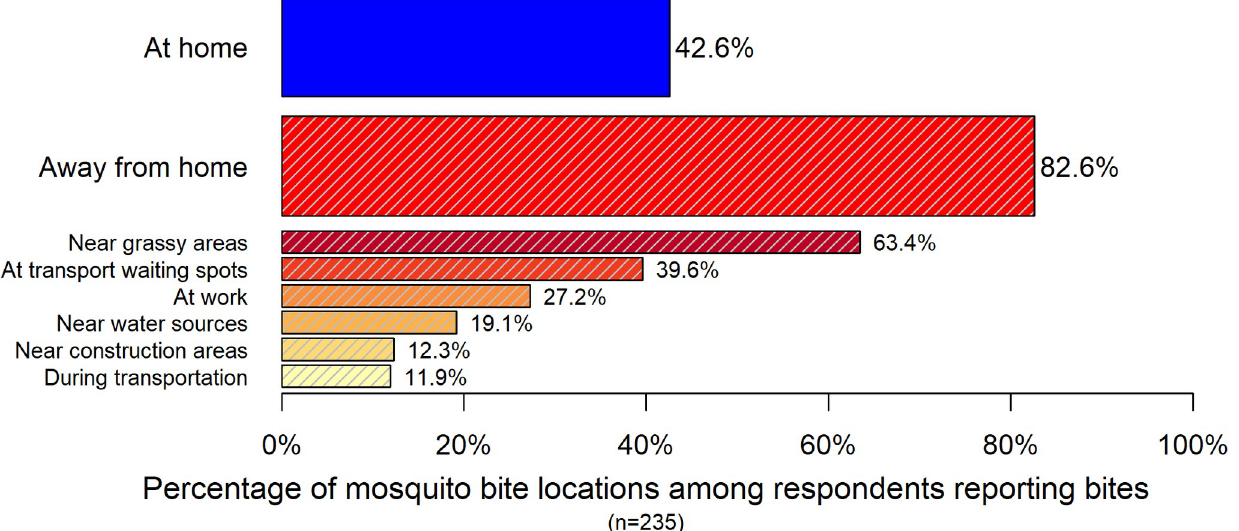
Fig 3. The locations of mosquito bites in August 2018. Note: reporting bites near grassy areas, at transport waiting spots, at work, near water sources, near construction areas and during transportation were merged as away from home. Respondents can choose more than 1 answer.